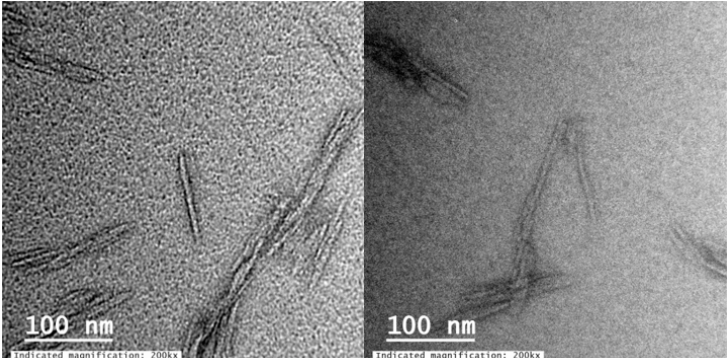
Figure 1. Transmission electron microscopy (TEM) micrographs of 2,2,6,6-Tetramethylpiperidine-1-oxyl (TEMPO)-oxidized cellulose nanocrystals (TOCNs) used in this work. Imaging techniques are described in Section 2.3.3.